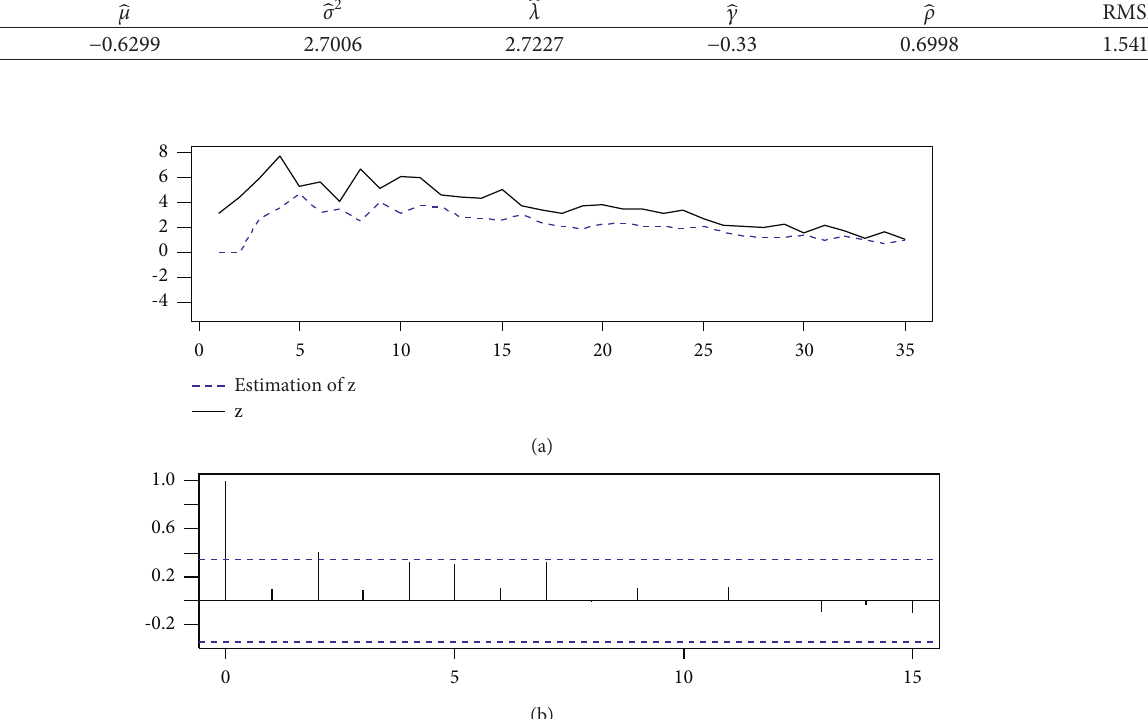
Figure 5: (a) Exact and estimated values of data based on Model (I). (b) ACF of residuals, h